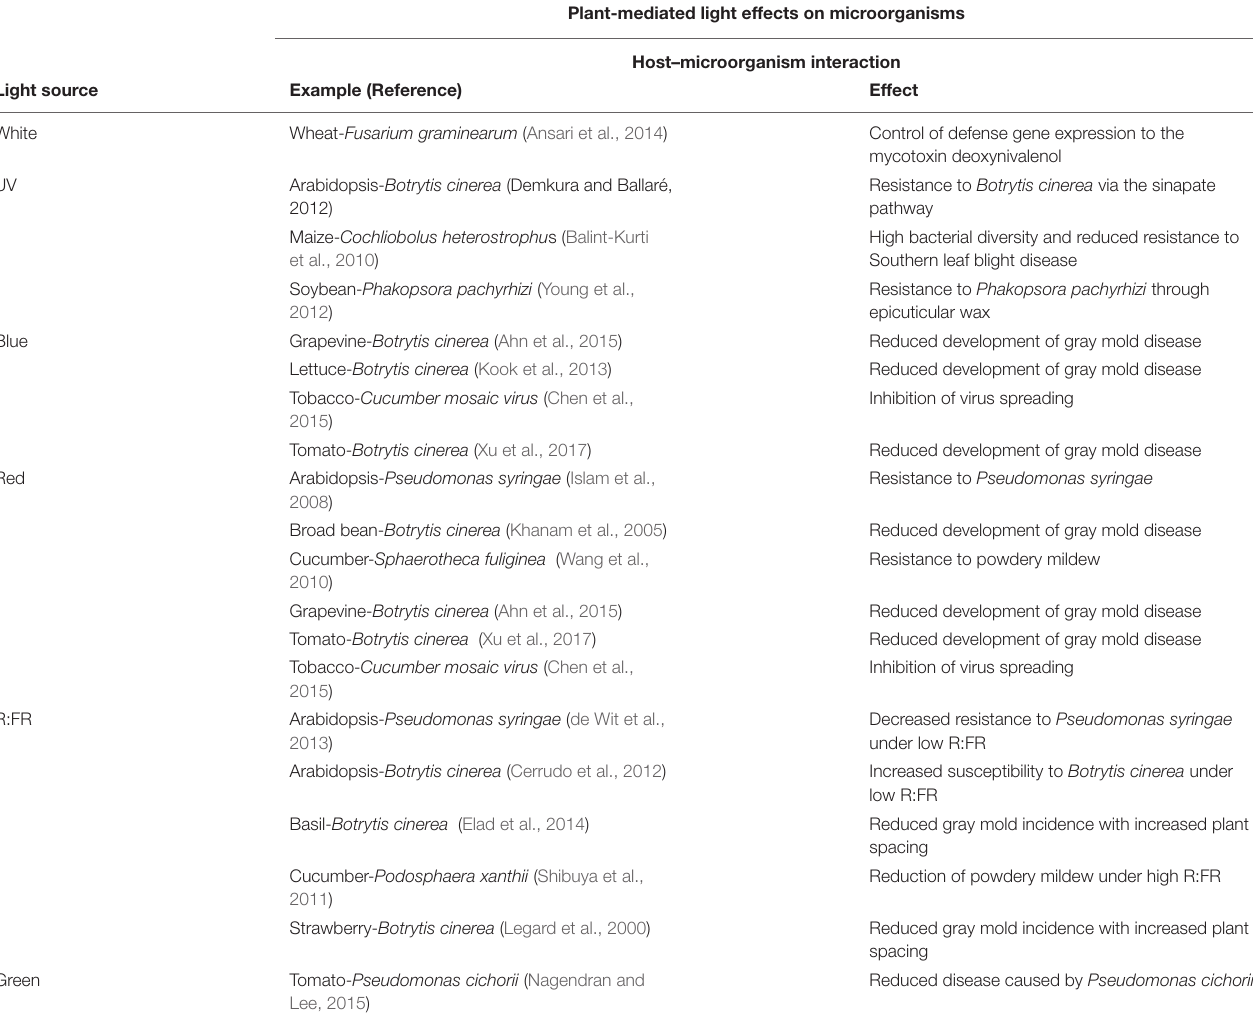
TABLE 4 | Plant-mediated light effects on plant–phyllosphere interactions, with examples of plant host–microorganism interactions affected by plant traits and effects of light